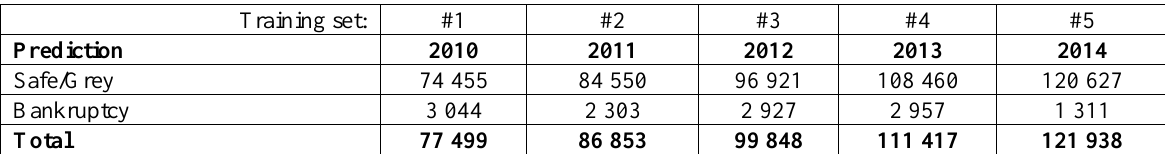
Table 5. Bankruptcy prediction based on ML-approach